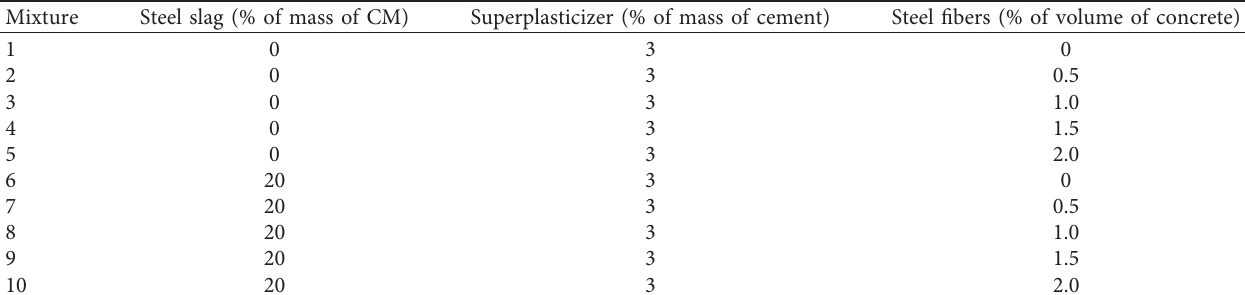
Table 2: Amounts of slag, steel fibers, and superplasticizer in each mixture.